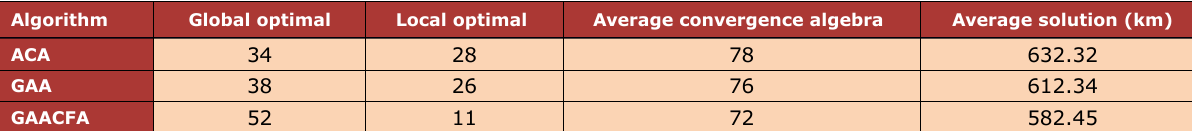
Table 3. Performance of the algorithms in P01